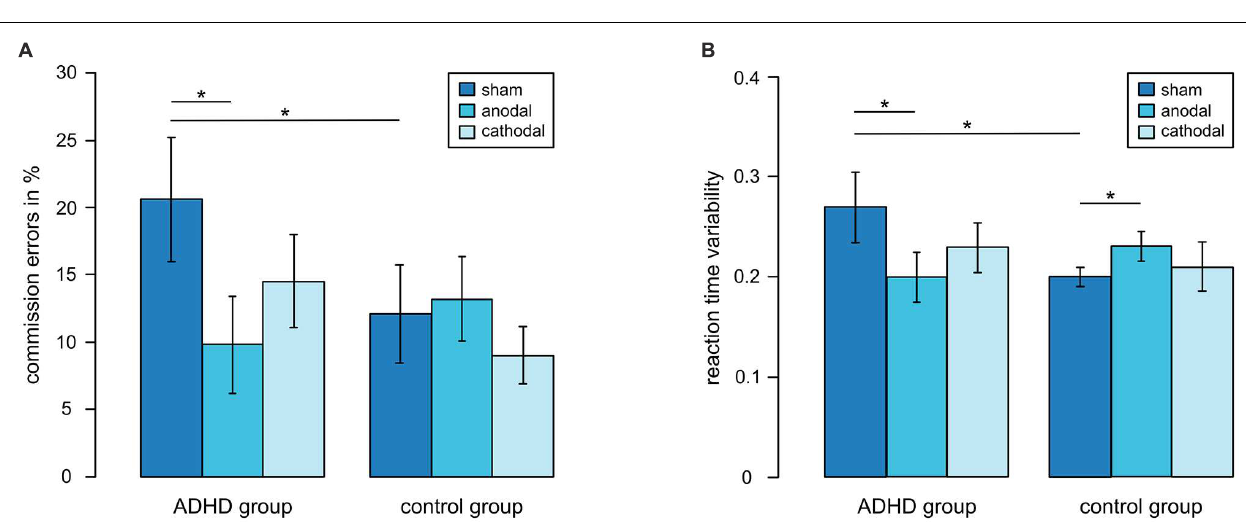
ADHD patients who received anodal tDCS was at the